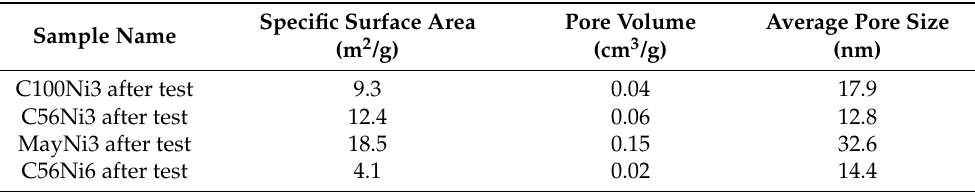
Table 10. Specific surface area, pore volume and average pore size of bi-functional compounds after